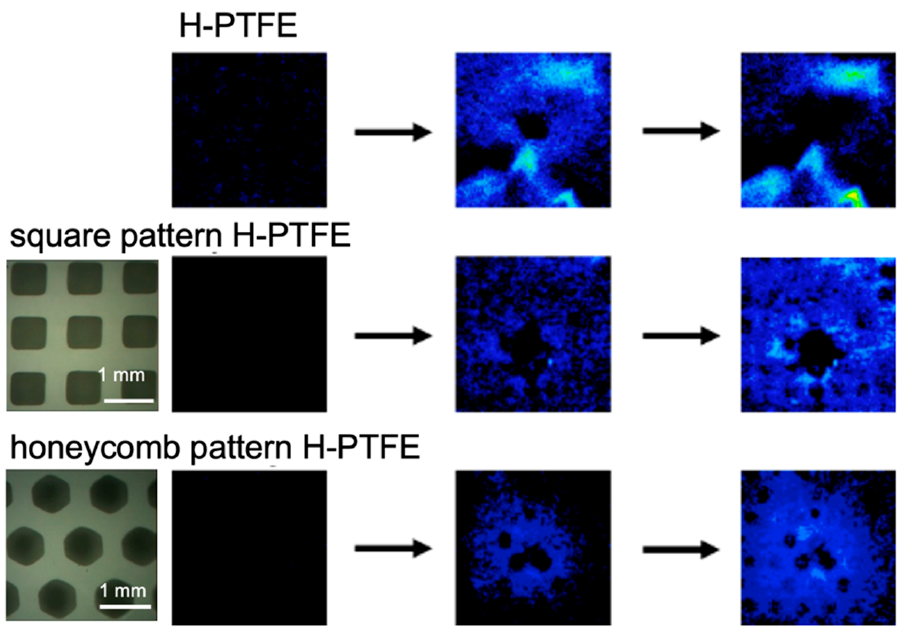
Figure 3. Change in fluorescence due to different pattern shapes (i.e., without pattern, square pattern, or honeycomb) of through-holes to suppress the accumulation of gas on the H-PTFE membrane. ( left 0 s, center 20 s, right 120 s).